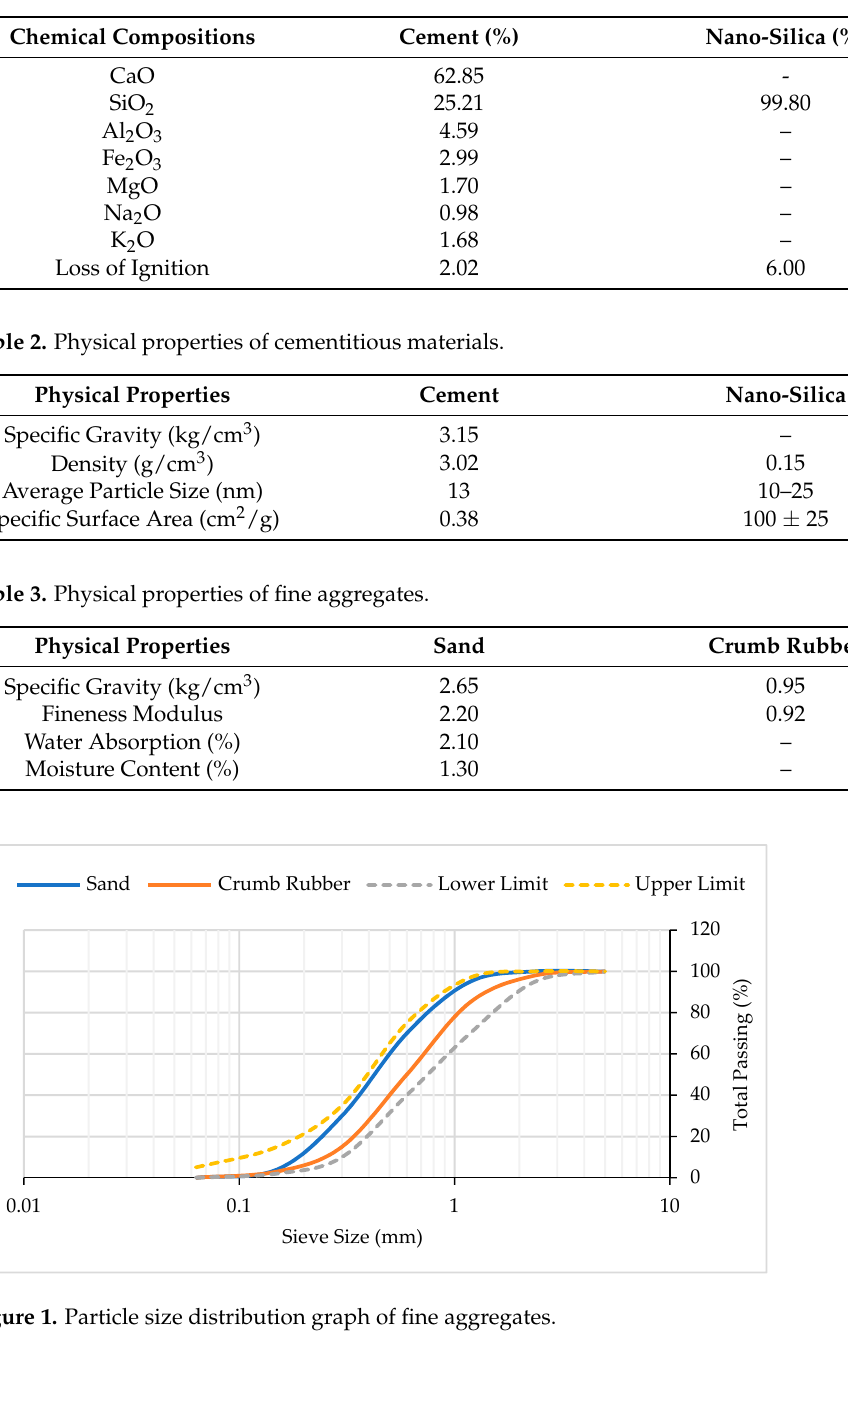
Table 1. Chemical compositions of cementitious materials.